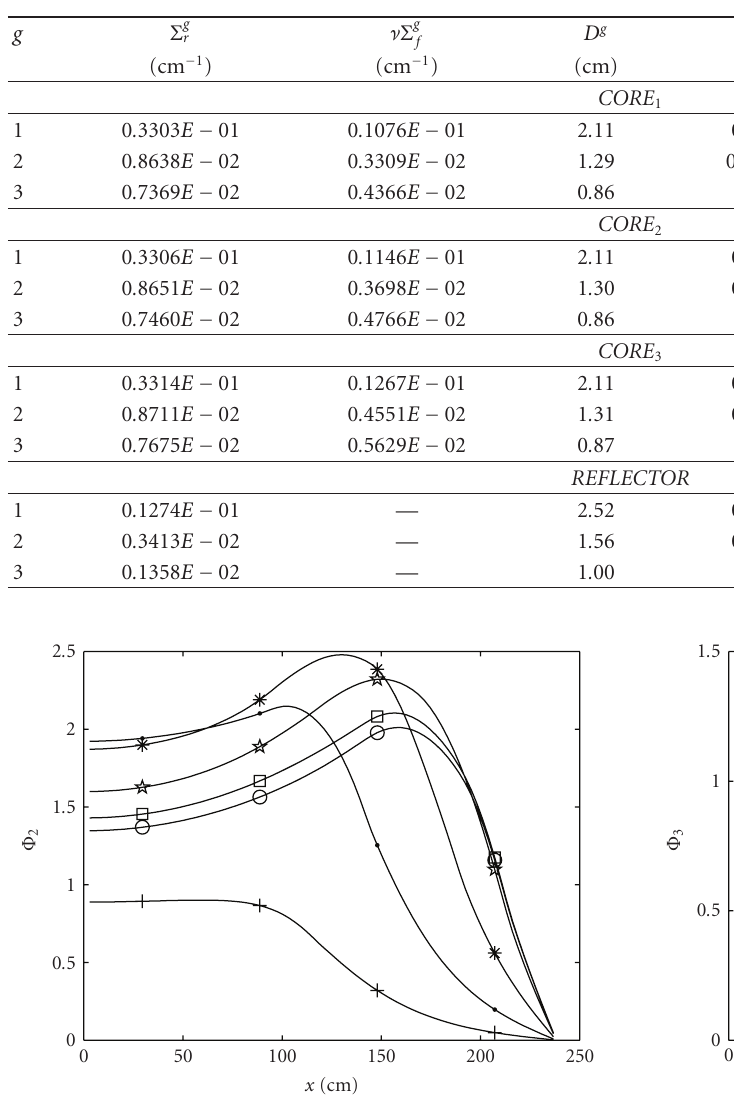
Table 5: Material data for the ELSY-like reactor.